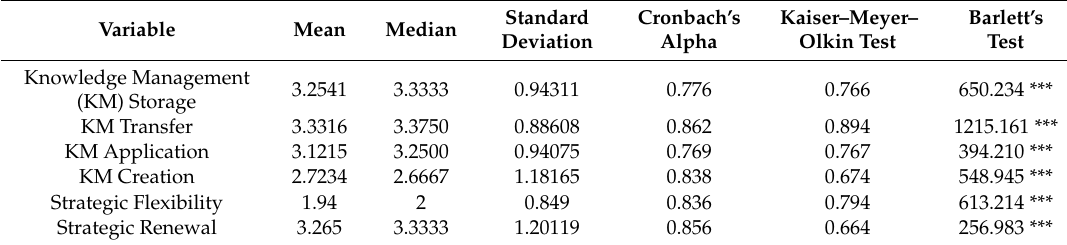
Table 2. Measures